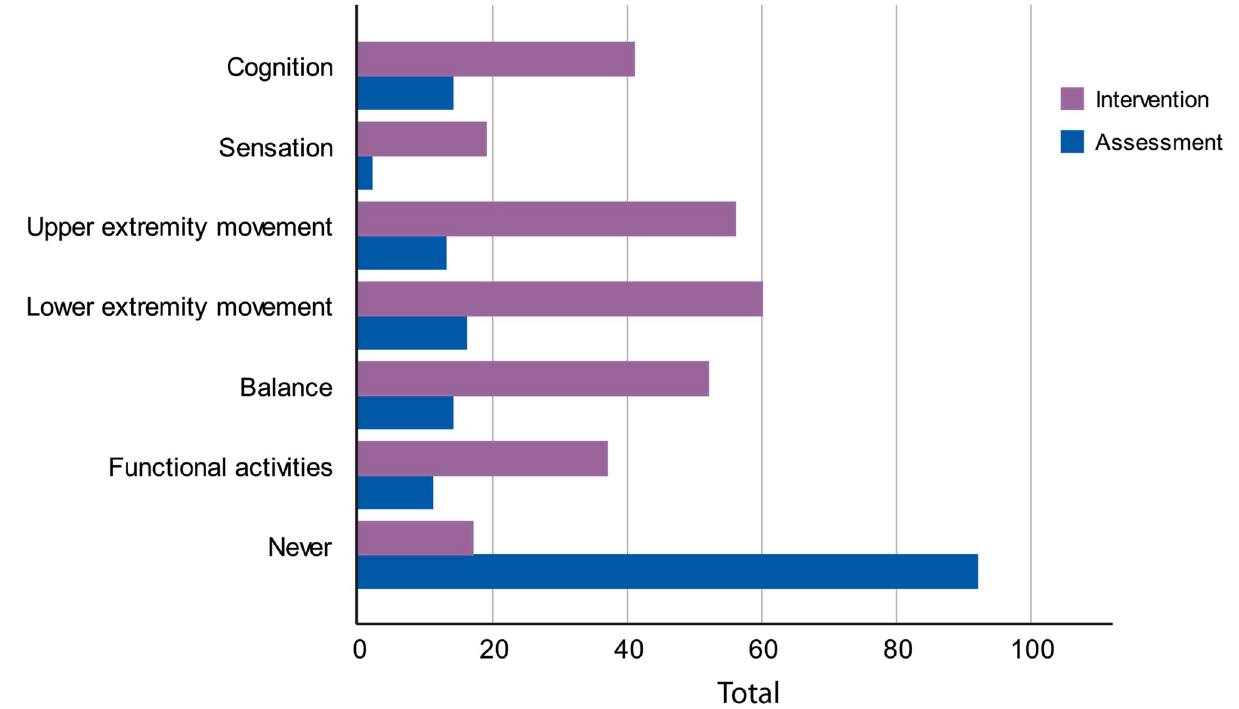
Fig 2. Adoption of technology for the purpose of either assessment or intervention. The number of responses did not always sum to 132 as participants were allowed to select multiple answers.